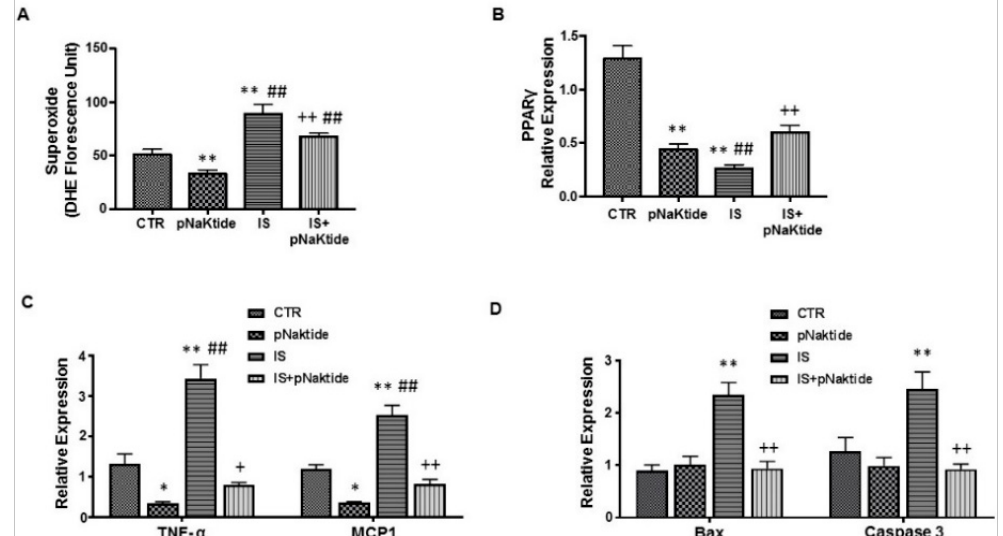
Figure 6. ( A ) MSC-derived adipocytes exposed to IS 50 µ M and treated with or without pNaKtide on superoxide levels assessed with DHE staining; ( B ) RT PCR analysis for the expression of adipogenic marker PPAR γ ; ( C ) RT PCR analysis for the expression of pro-inflammatory markers TNF- α and MCP-1; and ( D ) RT PCR analysis for the expression of pro-apoptotic markers Bax and Caspase 3. Values represent means ± SEM ( n = 4). * p < 0.05 vs. CTR, ** p < 0.01 vs. CTR, ## p < 0.01 vs. pNaKtide, + p < 0.05 vs. IS, ++ p < 0.01 vs. IS.